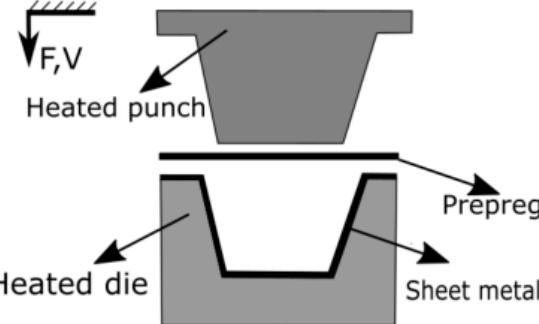
Figure 4. Experimental setup employed for manufacturing of hybrid components.